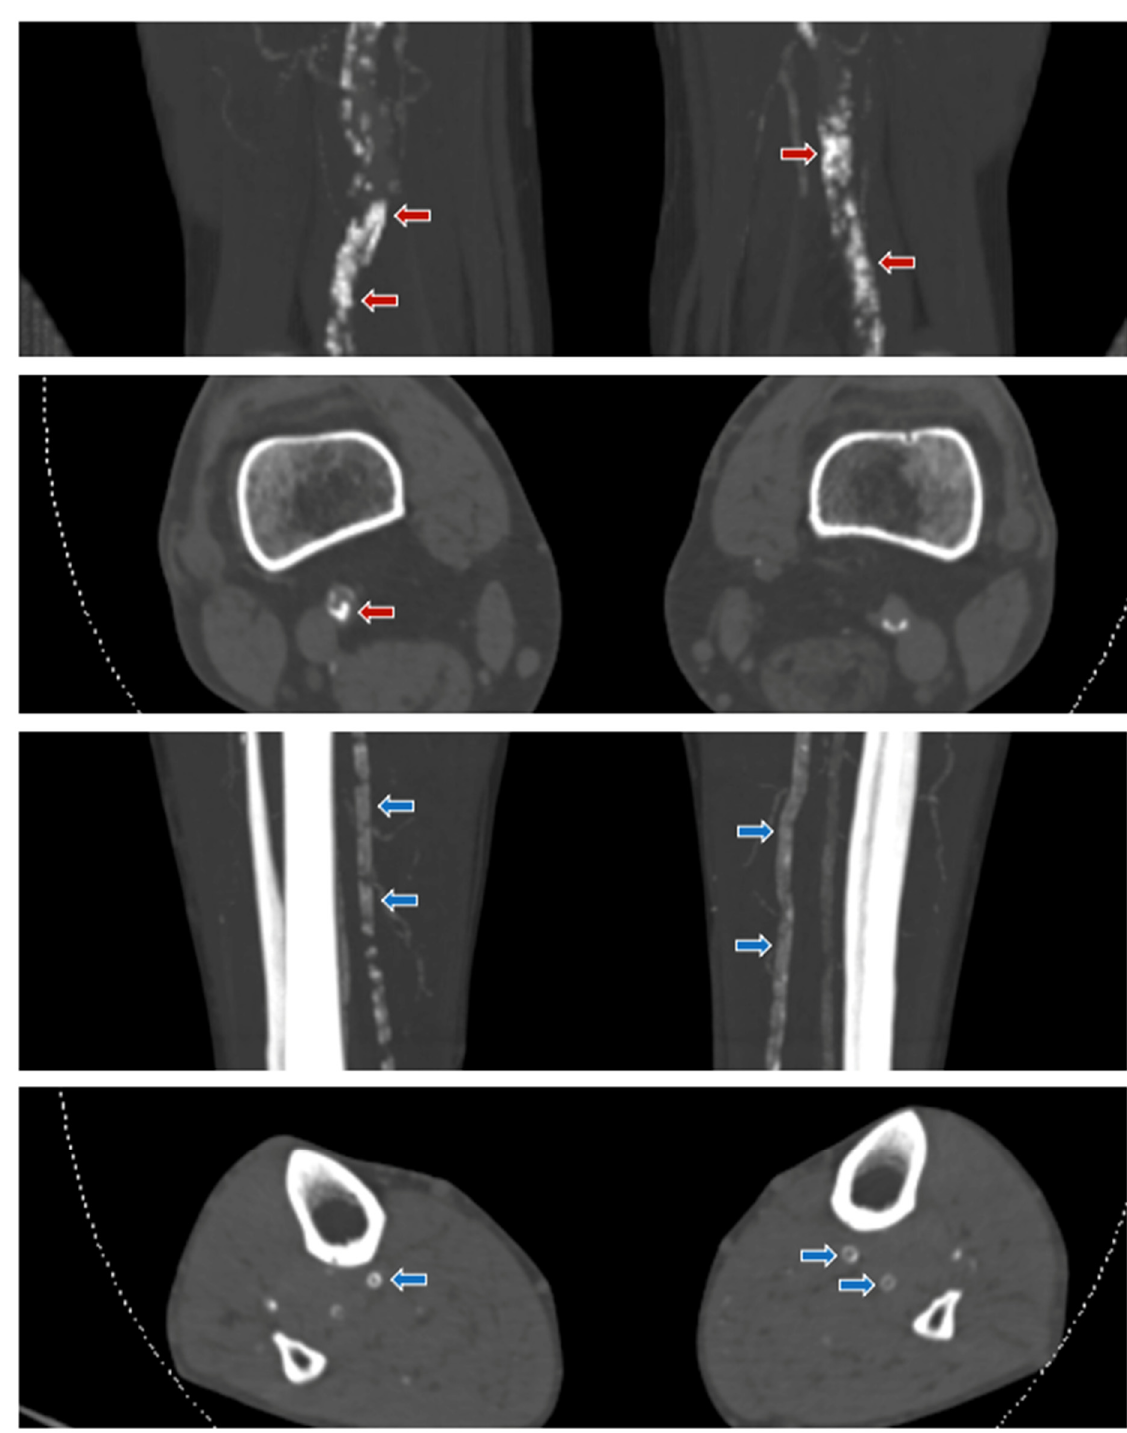
Figure 2. Examples of different calcification patterns in patients with CLI. Shown are coronal MIP and axial 3 mm CT angiography images of the lower extremities. A. Top two figures: the red arrows in femoropopliteal arteries showing irregular/patchy, thick, and non-annular calcifications corresponding to a dominant intimal calcification pattern. B. Bottom two figures: the blue arrows in the crural arteries showing continuous, thin, and annular calcifications corresponding to a dominant medial calcification pattern.